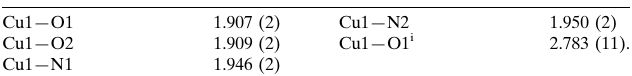
Selected bond lengths (A˚ ).